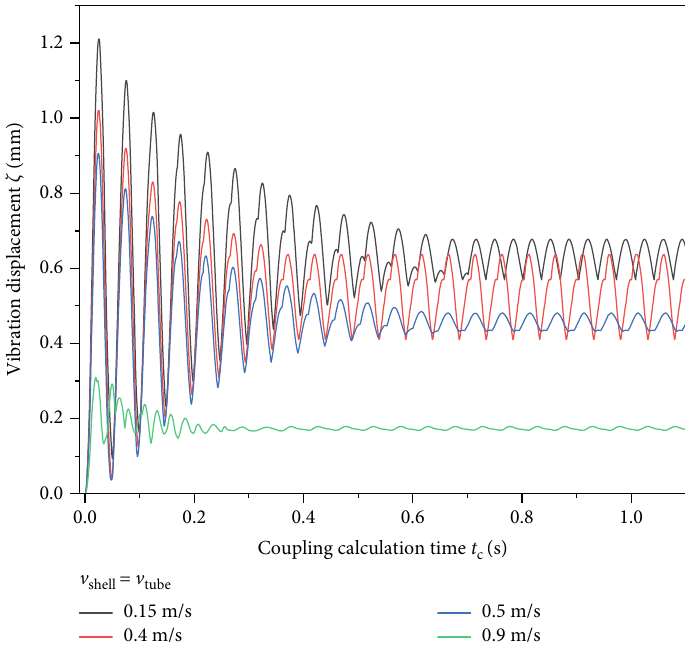
Figure 5: The total vibration deformation with the coupling calculation